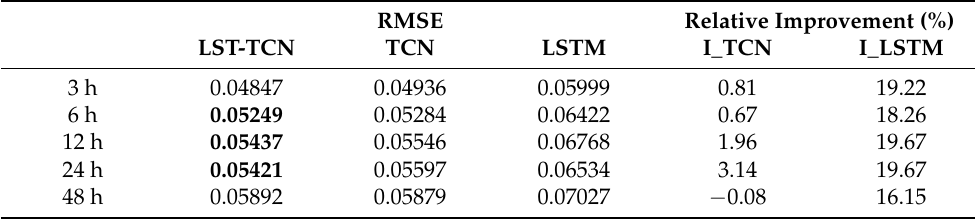
Table 4. RMSE error of each